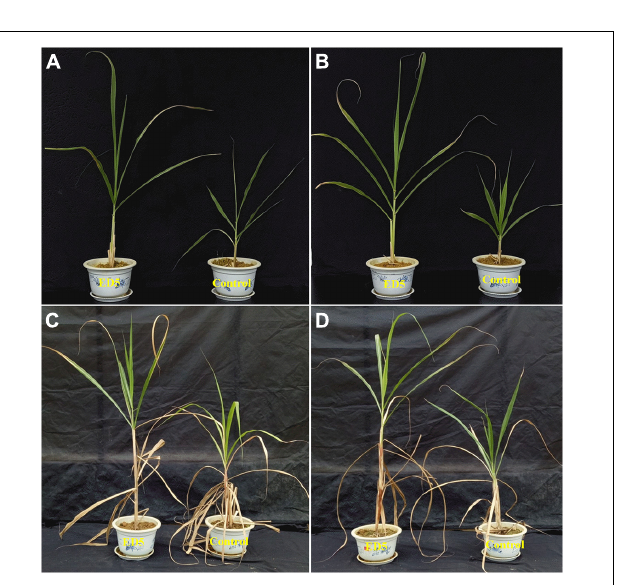
FIGURE 3 | Sugarcane growth promotion by inoculation of E. roggenkampii ED5 as compared to control. (A) GT11 (30 days), (B) B8 (30 days), (C) GT11 (60 days), and (D) B8 (60